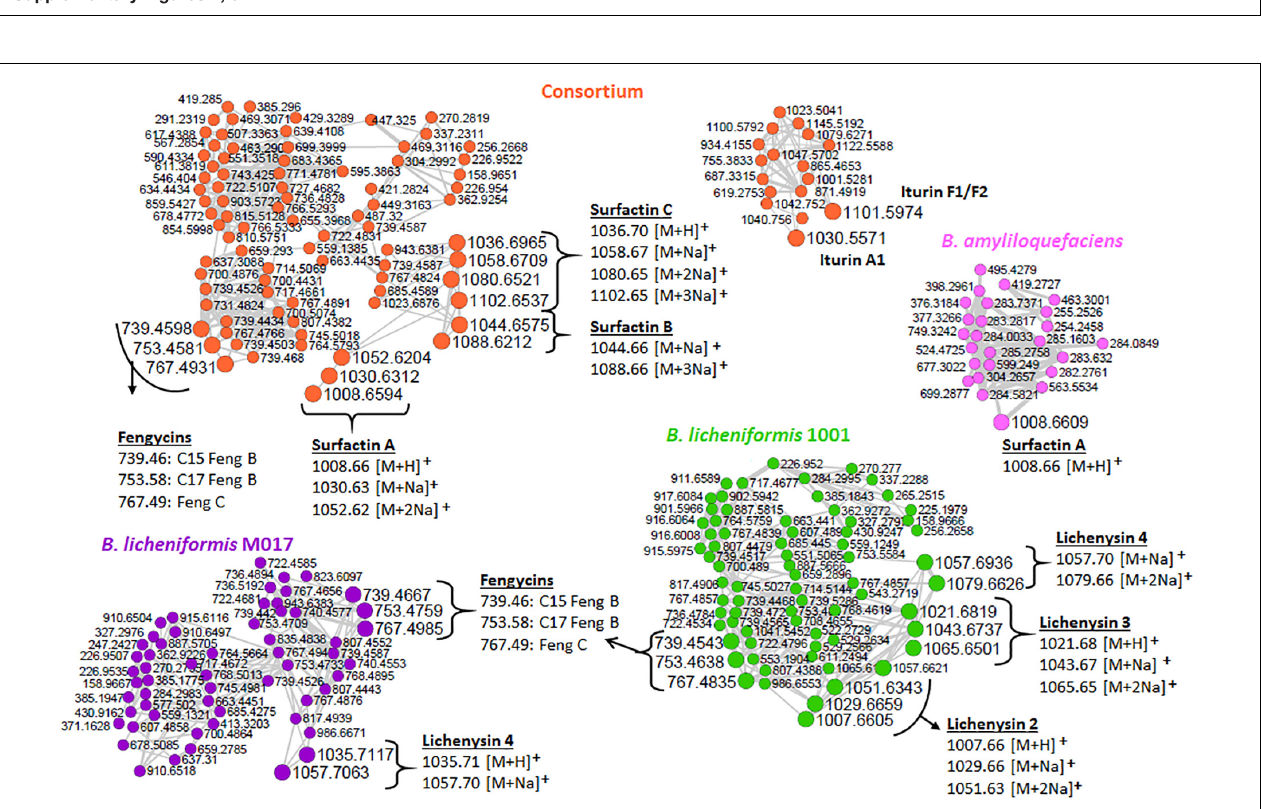
FIGURE 3 | Lipopeptide clusters extracted from the networks of isolates and the consortium (full networks in Supplementary Figure 2 ). Different node colors represent different strains, orange (consortium), pink ( B. amyloliquefaciens ), green ( B. licheniformis 1001), and purple ( B. licheniformis M017). Feng, fengycin.